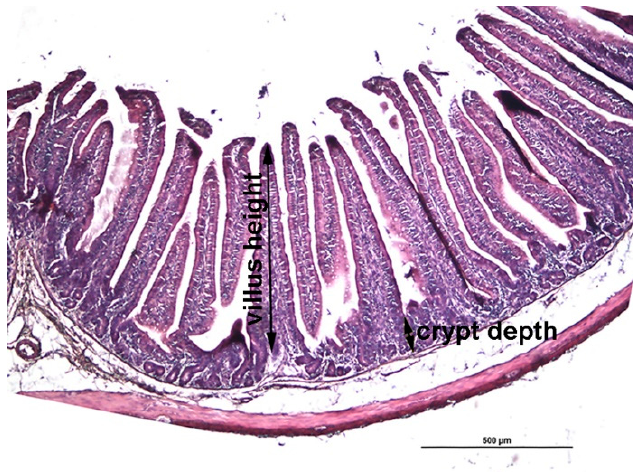
Figure 1. A representative histological cross section of jejunum. Villus height was measured from the tip of the villus to the crypt-villus junction and the crypt depth was measured from the crypt-villus junction to the base of the crypt as indicated. H&E staining; scale bar 500 μ m. junction to the base of the crypt as indicated. H&E staining; scale bar 500 µ